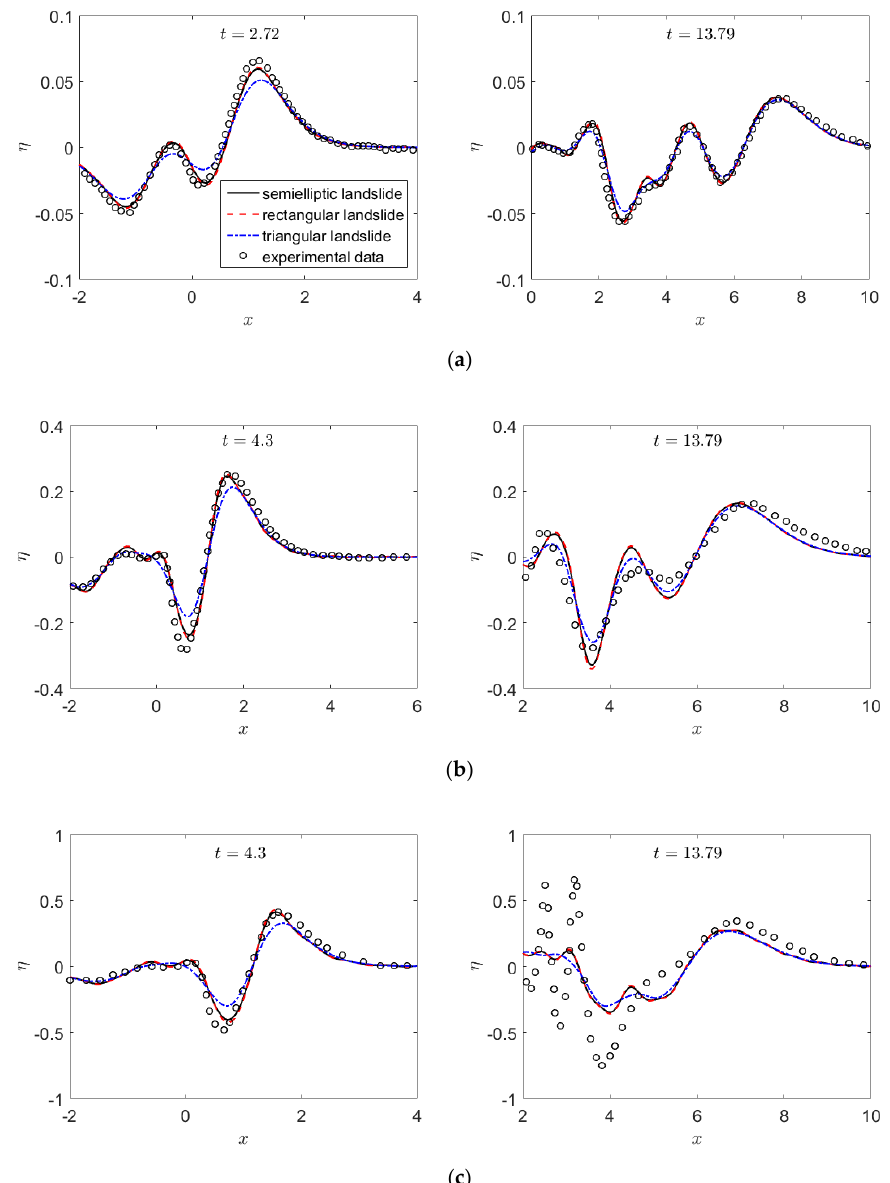
Figure 2. Comparisons of free surface elevations obtained by the linear fully dispersive (LFD) model and experimental data in [51] (note that dimensionless variables are used). ( a ) Run 21 (experimental data from Figures 8.1 and 8.3 in [51]). ( b ) Run 23 (experimental data from Figures 8.17 and 8.19 in [51]). ( c ) Run 24 (experimental data from Figures 8.24 and 8.26 in